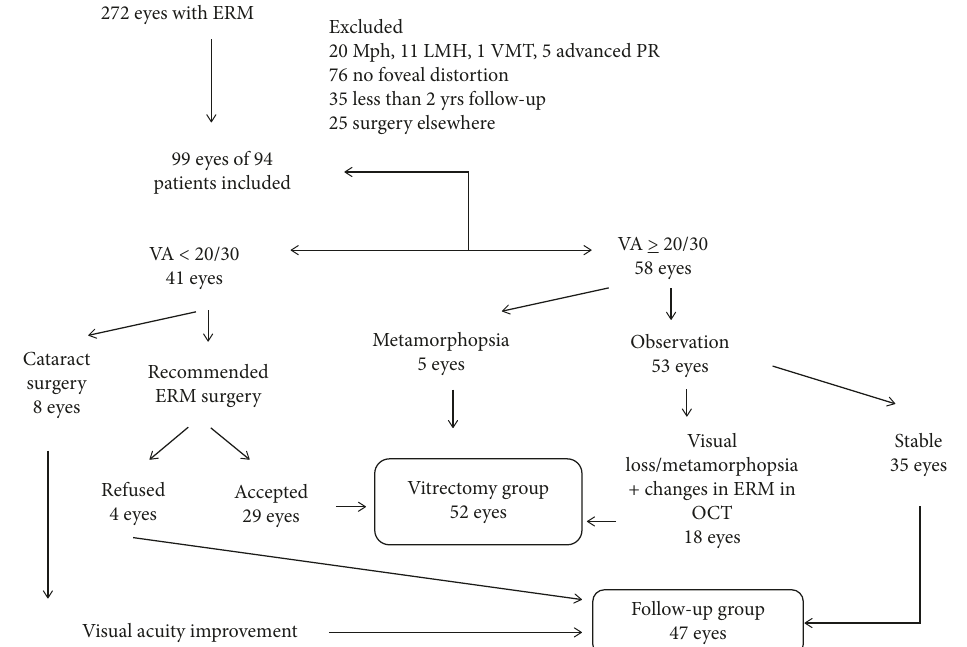
Figure 1: Flowchart showing patients included in the study, in the vitrectomy or follow-up group. ERM, epiretinal membrane; MPH, macular pseudohole; LMH, lamellar macular hole; PR, pigmentary retinosis; yrs, years; OCT, optical coherence